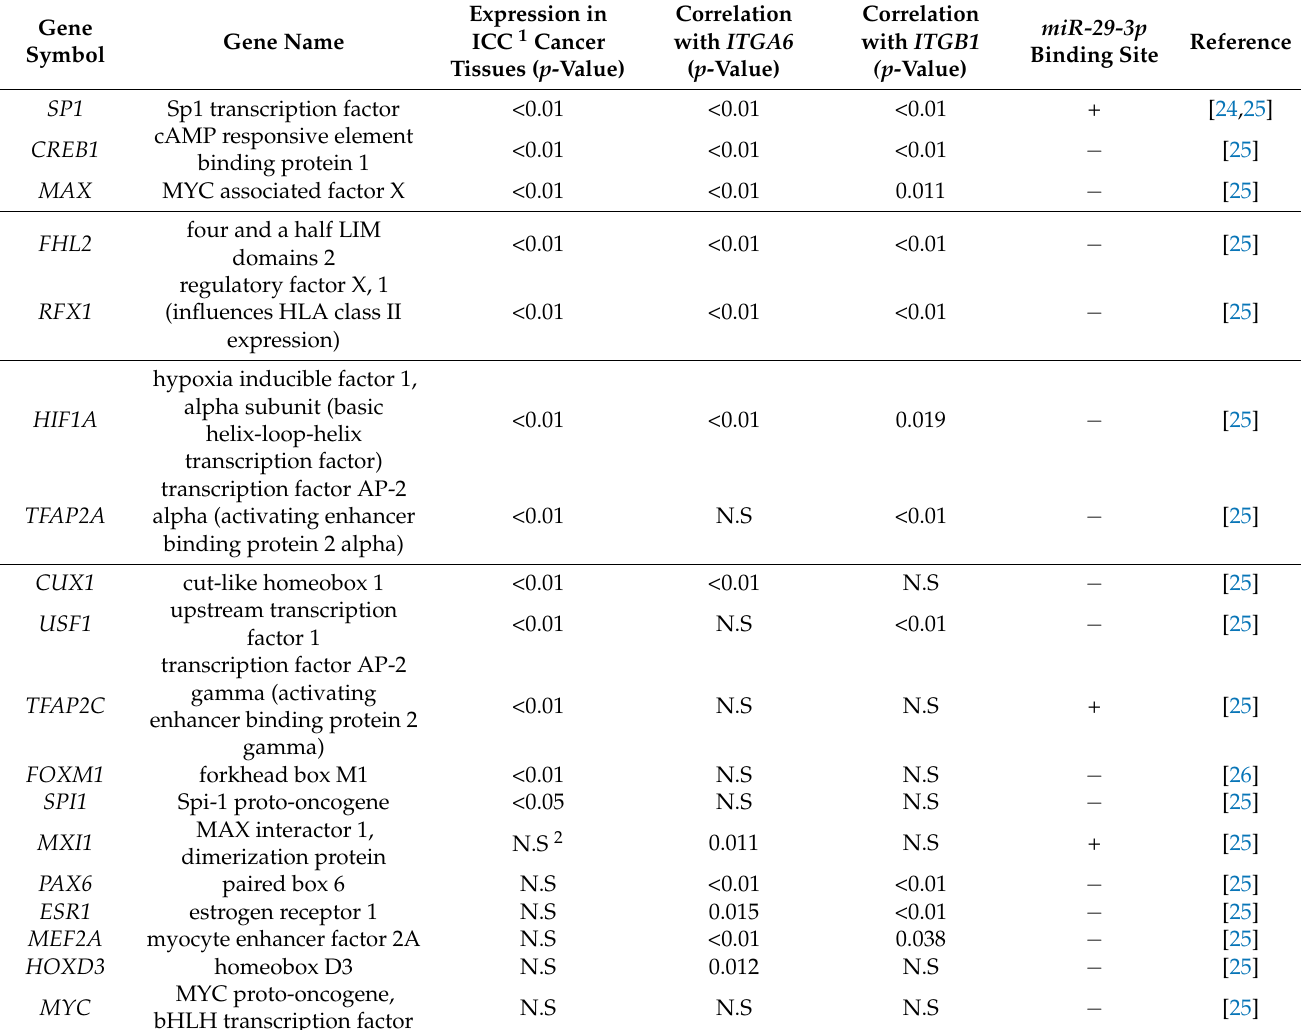
Table 2. Transcription factors for ITGA6 or